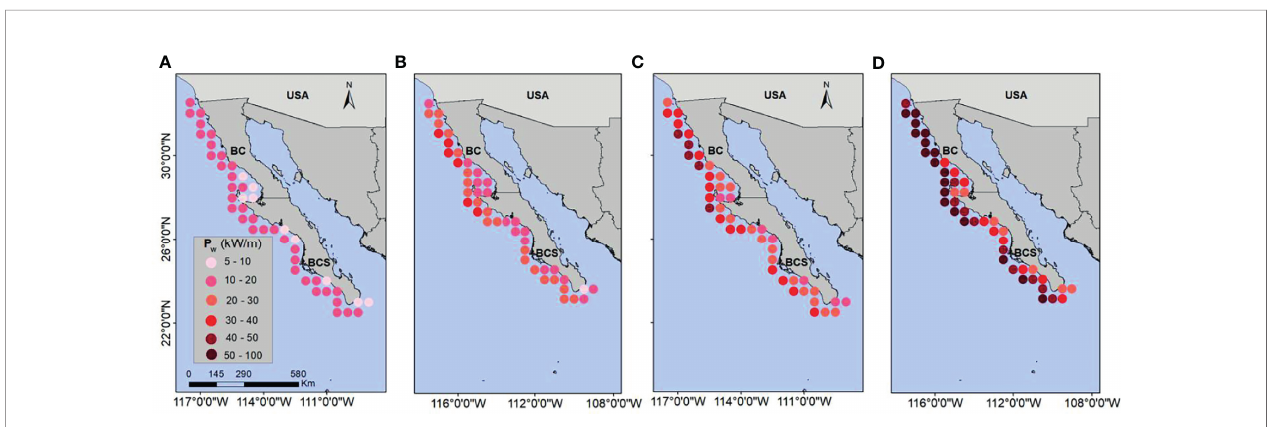
FIGURE 3 | Wave Power: (A) Annual average, (B) annual average of percentile 90%, (C) annual average of percentile 95%, and (D) annual average of percentile